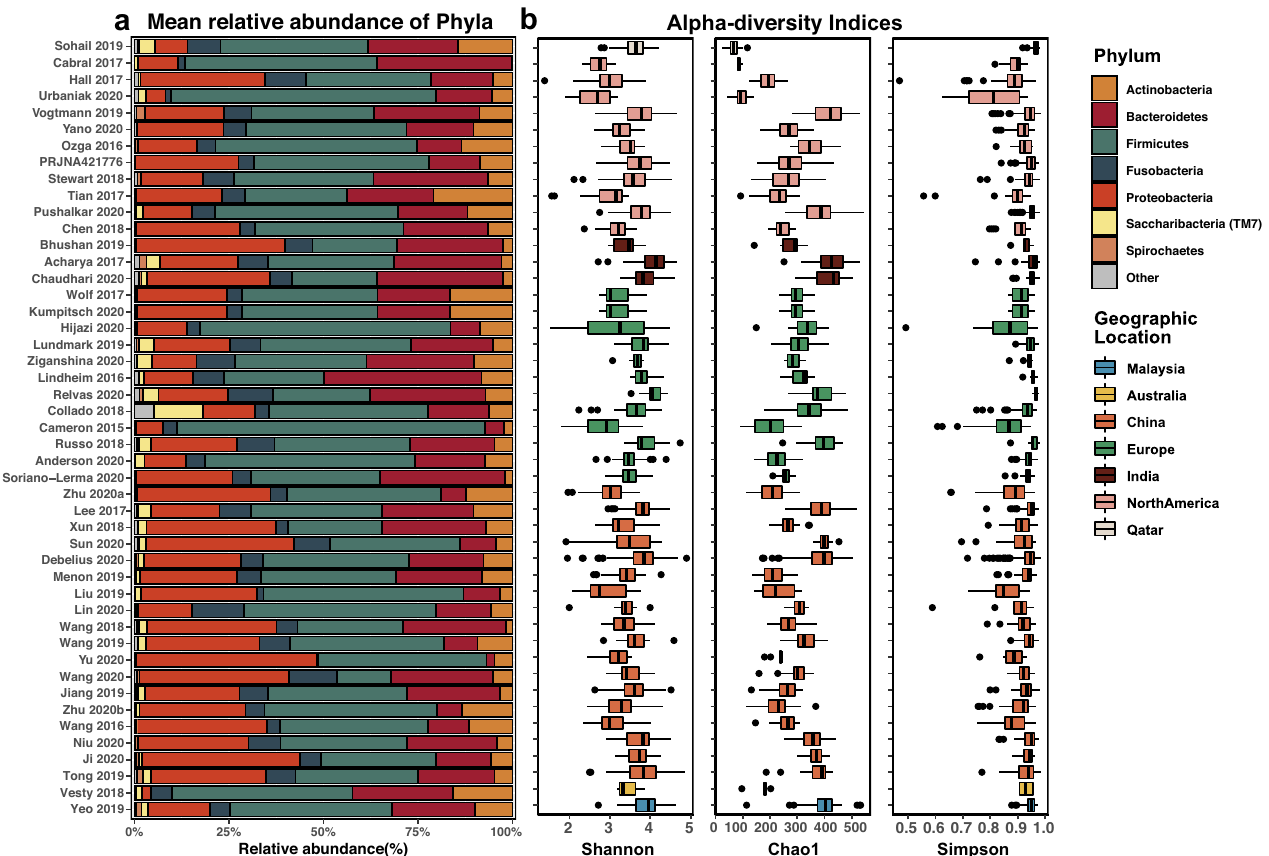
Fig. 2 Taxonomic composition and alpha diversity of included studies. a The mean community composition of each study at the phylum level; b The alpha diversity measured by Shannon index; Chao1 index and Simpson ’ s index, the colour of boxes stand for the geographic location of the studies. The horizontal bars within boxes represent medians. The tops and bottoms of boxes represent the 75th and 25th percentiles, respectively. The whiskers represent ±1.5× the interquartile range. The other boxplots in this study follow the same de fi